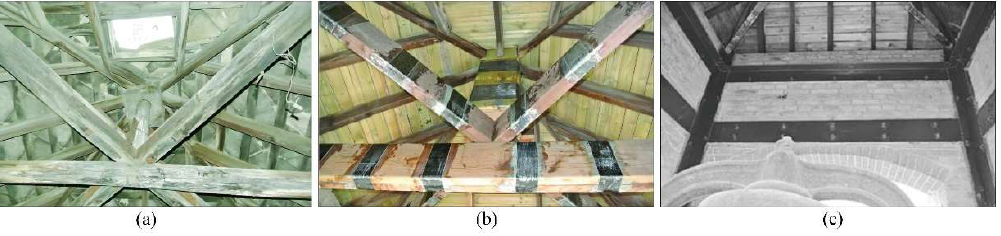
Figure 23. Tower strengthening (source: author). ( a ) Broken tower roof truss ( b ) Tower roof truss strengthening ( c ) Tower wall strengthening.